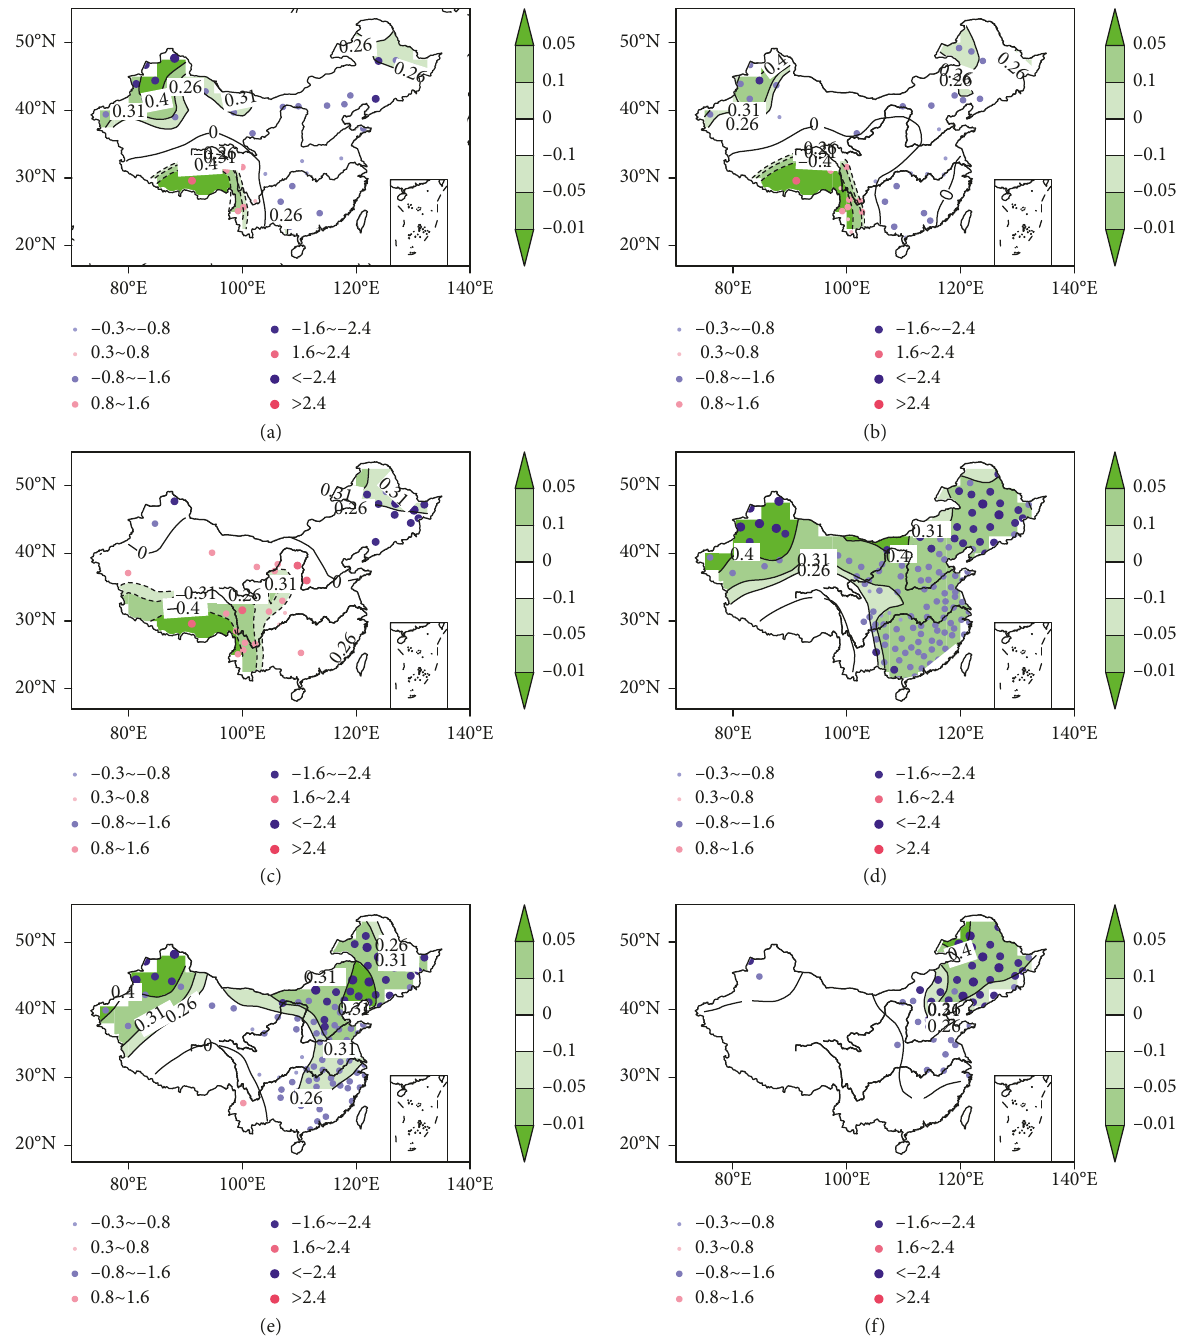
Figure 3: Correlation coefficients between the BKI for September (a, d), October (b, e), and November (c, f) and the winter (DJF) temperature time series for 160 stations in China (shaded: significance and contour: correlation coefficient values) and the composite differences in the temperatures (dots; unit: ° C) between selected low BKI years and high BKI years. The upper panels are for the OBKI, and the bottom panels are for the DBKI. Both the shaded areas and the dots indicate values that are statistically significant with significance exceeding 0.1 based on the results of t -tests. The values in the color bar represent the significance levels of the t